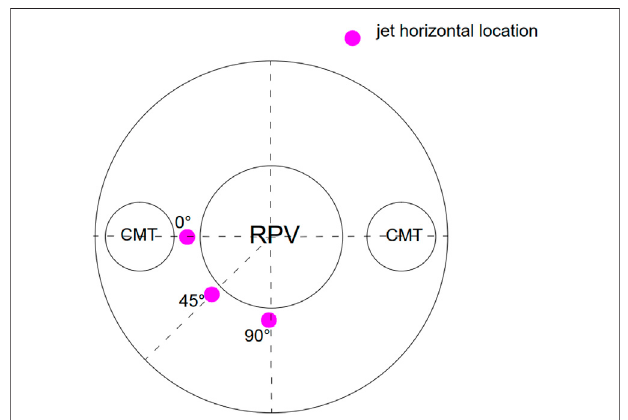
FIGURE 3 | Top view of various jet horizontal locations.